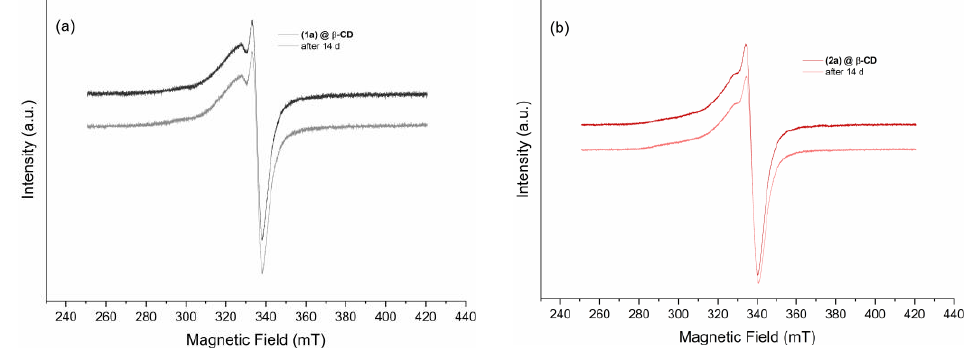
Figure 9. EPR spectra of ( 1a )@ β -CD ( a ) and ( 2a )@ β -CD ( b ) dissolved in DMSO measured at 9.88 GHz with a 100 mM concentration. Each spectrum was also remeasured after 14 days to evaluate the stability of the two complexes in the solution.